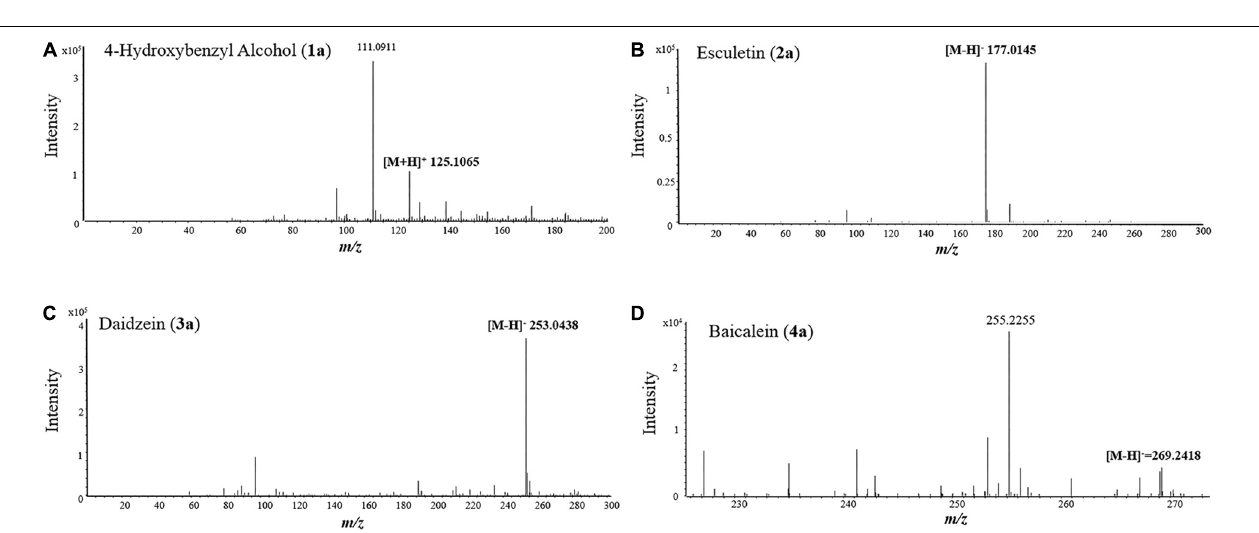
FIGURE 5 | HPLC analysis of the transformation products of gastrodin (A) , esculin (B) , daidzin (C) and baicalin (D) by recombinant TtBgl3 for 12 h. Gastrodin (1); 4-hydroxybenzyl alcohol (1a); esculin (2); esculetin (2a); daidzin (3); daidzein (3a); baicalin (4); baicalein (4a).